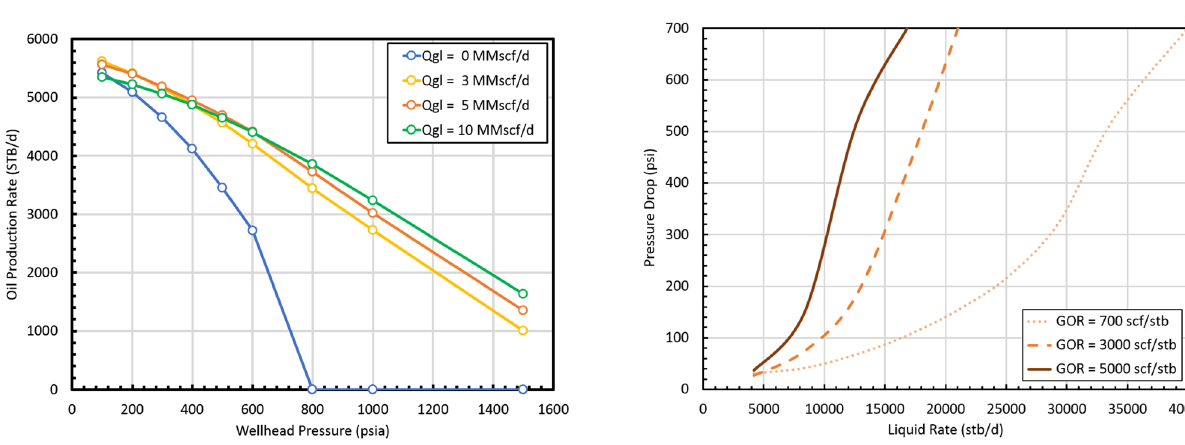
Fig. 3 Example of a well performance model for a well of reservoir A with a reservoir pressure of 3500 psia, producing GOR of 800 scf/stb and WC of 30%